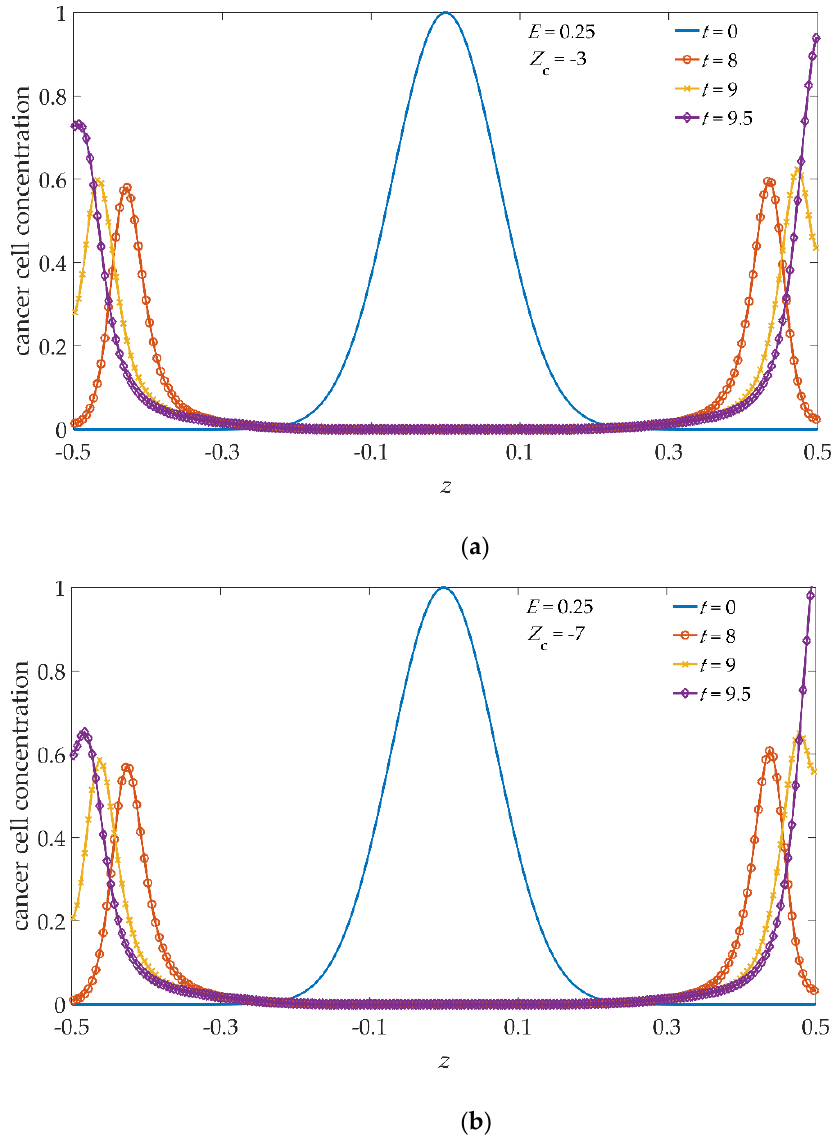
Figure 5. Profiles of the cancer cell concentration along the vertical cutline, applying a uniform electric field in the negative z -axis direction, with intensity E = 0.25. ( a ) Z c = − 3; ( b ) Z c = − 7. Snapshots are taken at t = 0 (blue), t = 8 (red/circle), t = 9 (yellow/cross), and t = 9.5 (purple/diamond).